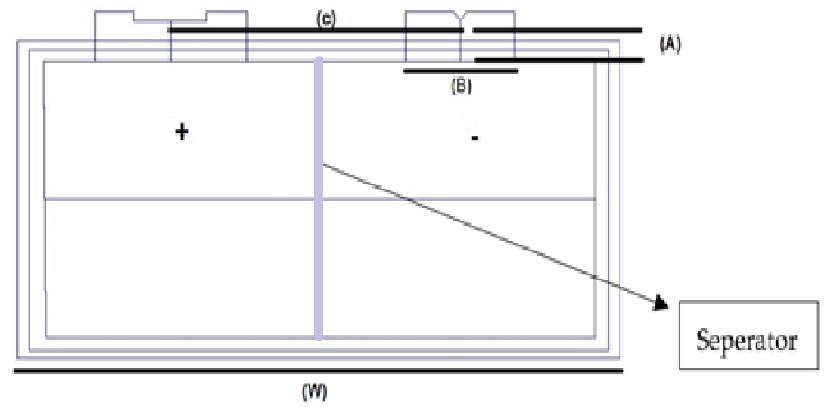
Figure 2. High-energy lithium pouch cell diagram.